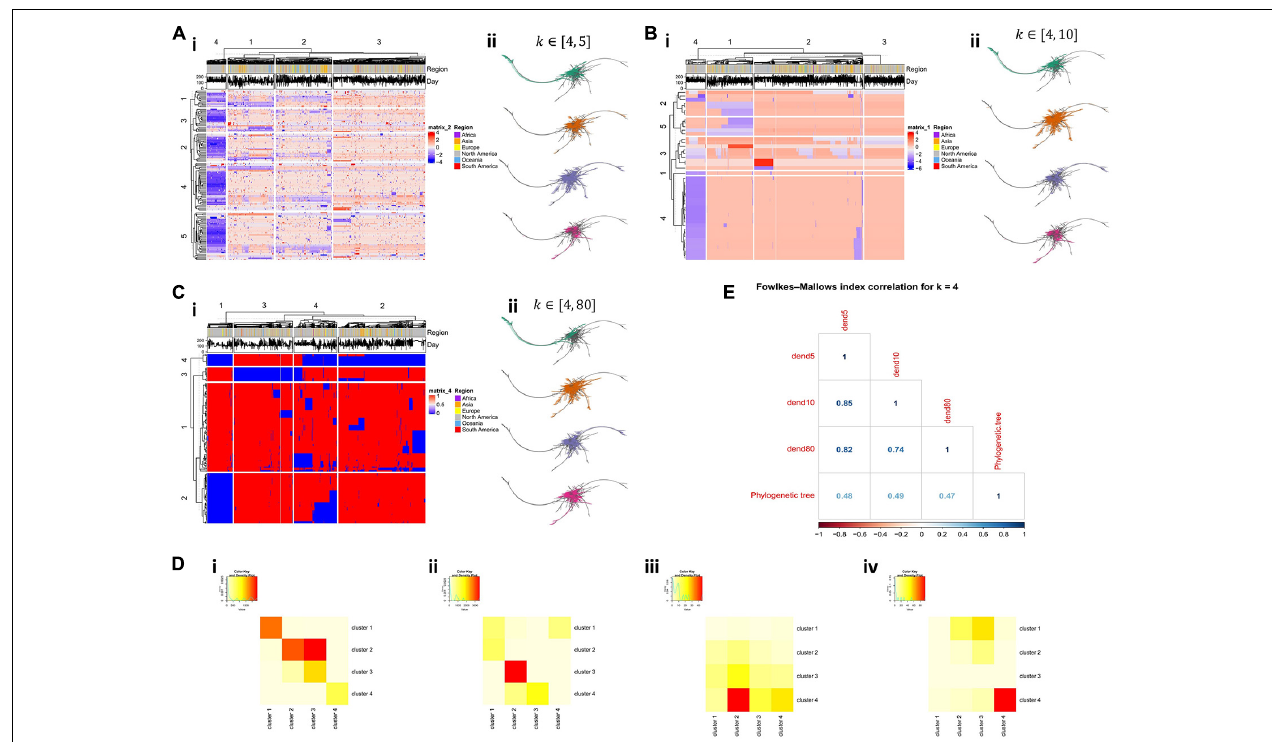
FIGURE 2 | Comparison of results produced by the investigation of multiple k -ranges. (Ai) Heatmap of produced features in the range of k ∈ [4 , 5] and (Aii) the projection of the underlying sequence clusters in the phylogenetic tree produced by the raw sequences. (Bi, ii) Heatmap and the projected sequence clusters on the phylogenetic tree for k ∈ [4 , 10]. (Ci, ii) Heatmap and the projected sequence clusters on the phylogenetic tree for k ∈ [4 , 80]. (Di) Overlap between sequence clusters for k ∈ [4 , 5] (depicted as columns) and k -mer clusters (depicted as rows) for k ∈ [4 , 10]. (Dii) Overlap between sequence clusters for k ∈ [4 , 10] (depicted as columns) and k -mer clusters (depicted as rows) for k ∈ [4 , 80]. (Diii) Overlap between sequence clusters for k ∈ [4 , 5] (depicted as columns) and k -mer clusters (depicted as rows) for k ∈ [4 , 10]. (Div) Overlap between sequence clusters for k ∈ [4 , 10] (depicted as columns) and k -mer clusters (depicted as rows) for k ∈ [4 , 80]. (E) Correlations based on the Fowlkes-Mallows index with 4 clusters, between the three sequence dendrograms (generated for the three ranges) and the phylogenetic